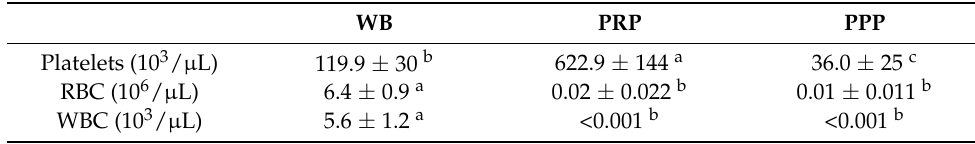
Table 1. Platelets, red blood cells (RBC) and white blood cells (WBC) in the whole blood (WB), platelet- rich (PRP), and platelet-poor (PPP) plasma obtained from 96 venipunctures from mares susceptible to persistent breeding-induced endometritis. Each mare cycle was assigned in a crossover-designed to either PRP ( n = 12), PPP ( n = 10), or control ( n = 12) group. WB